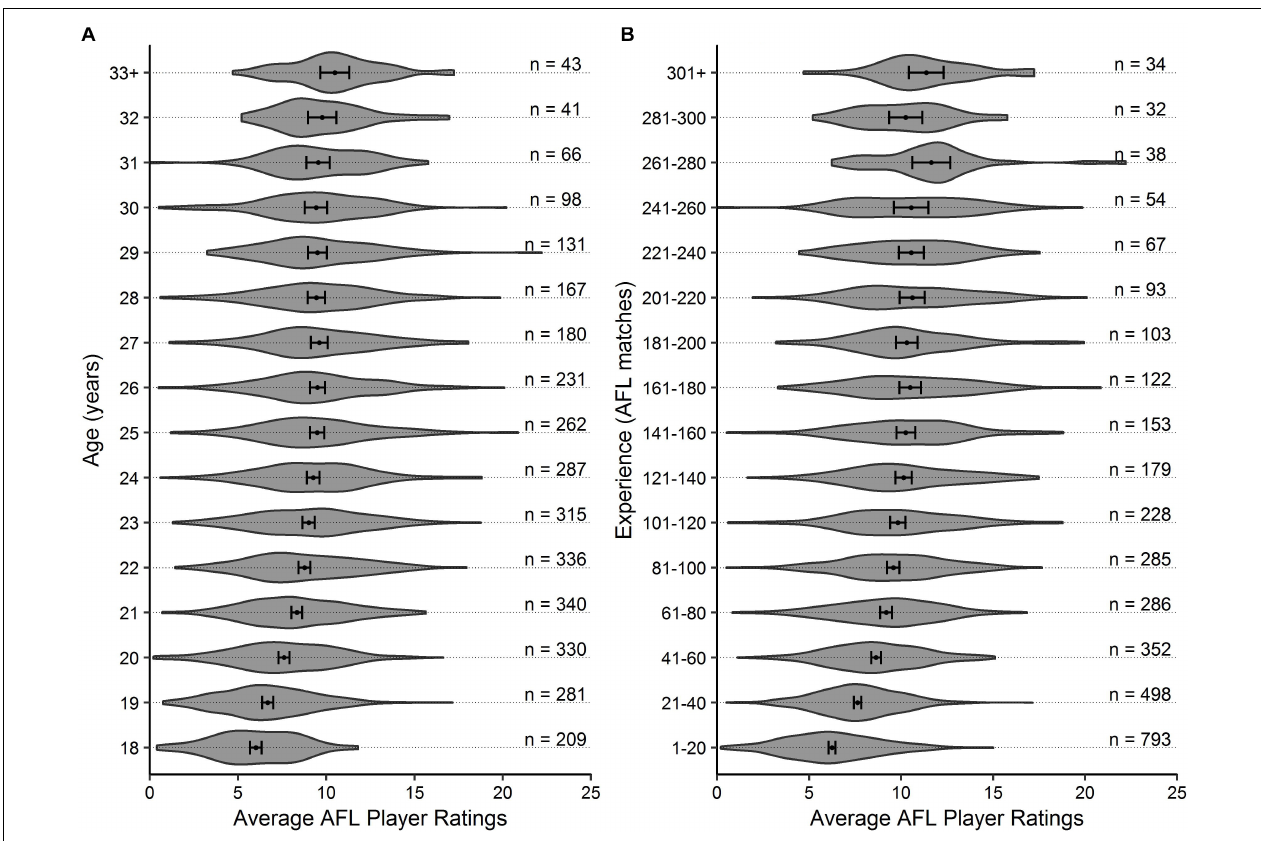
FIGURE 1 | Violin plot outlining the density of the average AFL Player Ratings ( ± 95% CI) for (A) age and (B) experience, respectively. The number of observations in each group are outlined.